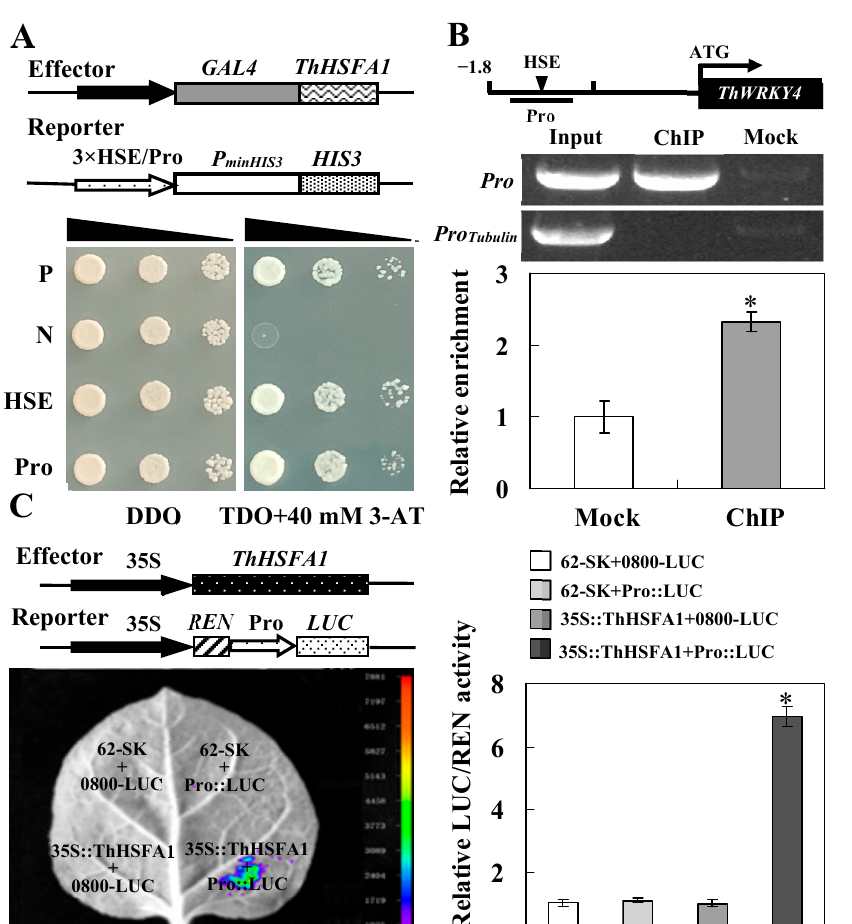
Figure 1. Identification of the upstream regulator ThHSFA1 of ThWRKY4. ( A ) Y1H assay. Three tandem copies of cis-acting HSE and the ThWRKY4 promoter fragment (Pro) were inserted into the pHIS2 vector. The reporter and effector constructs were co-transformed into yeast Y187 cells, and transformed cells were identifying by spotting serial dilutions of yeast onto selective medium SD/ − Leu/ − Trp (DDO) and SD/ − Leu/ − Trp/ − His (TDO) containing 3-amino-1,2,4-triazole (3-AT). P: positive control (p53HIS2 + pGAD-53); N: negative control (p53HIS2 + pGAD-ThHSFA1). ( B ) ChIP assay. Simplified ThWRKY4 gene structure showing the ThHSFA1 binding regions (Pro) and the cis-acting HSE. qPCR analysis of the abundance of the ThWRKY4 promoter fragment. Input, chromatin preparation before immunoprecipitation; ChIP, immunoprecipitated with an anti-GFP antibody; Mock, immunoprecipitated without an anti-GFP antibody. ( C ) Dual-luciferase reporter assay. A schematic of the recombinant effector (35S::ThHSFA1) and reporter (Pro::LUC) constructs used for the transient expression assays is shown. The effector and reporter vectors were simultaneously co-transformed into N . benthamiana leaves, and the luminescence intensity was measured. Tobacco leaves injected with 0800-LUC+ 62-SK, Pro::LUC+62-SK and 0800-LUC+35S::ThHSFA1 were used as negative controls. Luciferase activity is expressed relative to the control levels (value set at 1.0). The error bars represent ± SD from multiple biological replicates, and the asterisks indicate significant differences (*, p < 0.05).